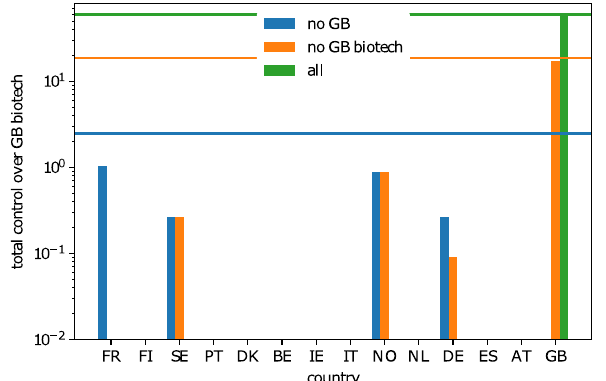
Figure 4. Distribution of the source of control over the GB biotech research sector along the various countries for a budget-restricted optimization. The budget is chosen to be B = €901M, which equals the total value of the target set of GB-biotech firms. The horizontal line indicate the total control achieved in the different policy